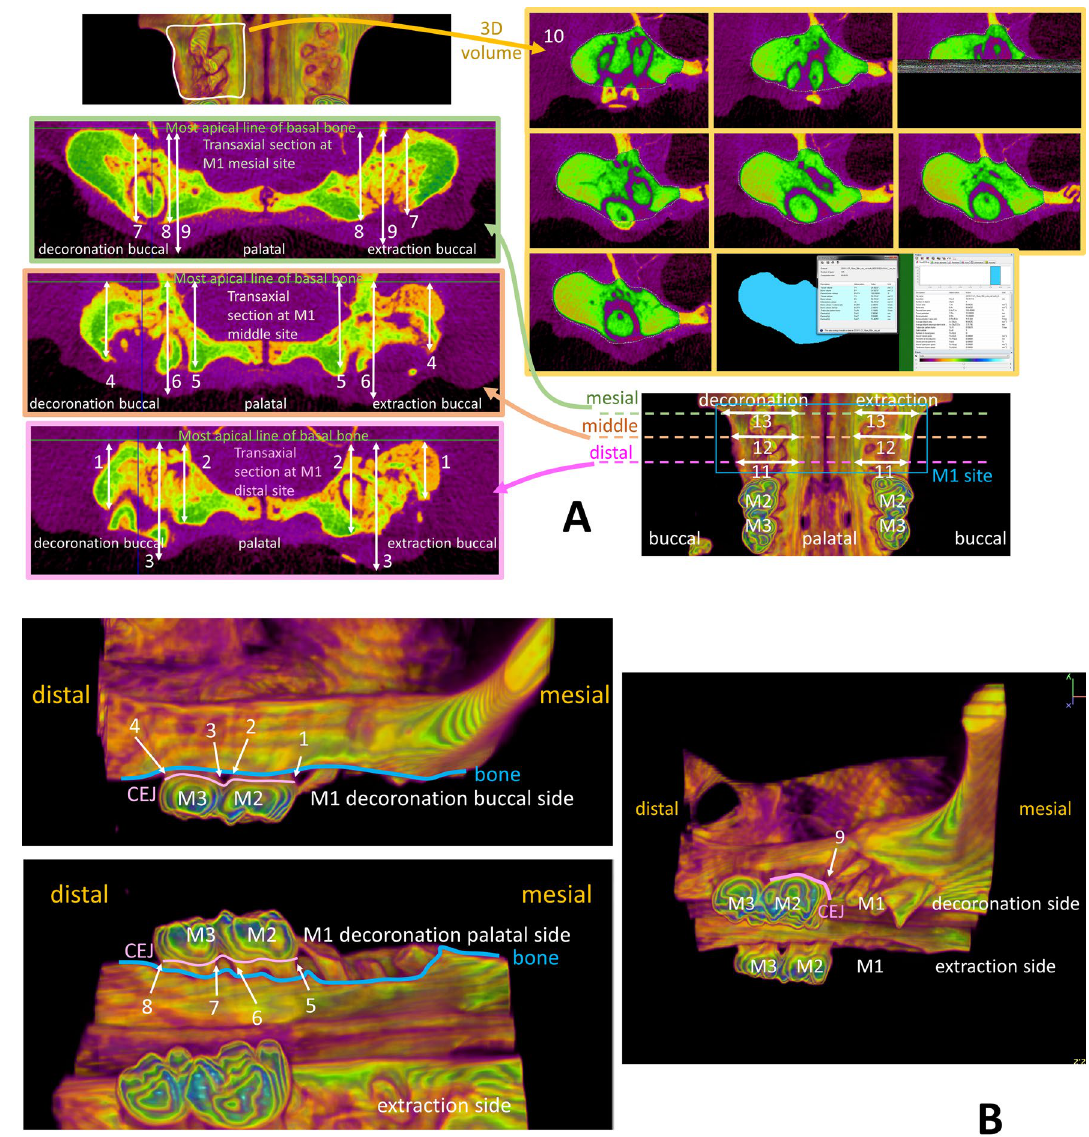
Figure 1. Micro-computed tomography assessments of alveolar bone and soft tissue dimension. ( A ) To evaluate the effectiveness of hard and soft tissue preservation of alveolar ridge dimension associated with the decoronation procedures, thirteen parameters were measured at maxillary first molar (M1) sites including (1) distal buccal bone height, (2) distal palatal bone height, (3) distal maximum soft tissue height, (4) middle buccal bone height, (5) middle palatal bone height, (6) middle maximum soft tissue height, (7) mesial buccal bone height, (8) mesial palatal bone height, (9) mesial maximum soft tissue height, (10) 3D bone contour volume*, (11) distal maximum alveolar ridge width, (12) middle maximum alveolar ridge width, and (13) mesial maximum alveolar ridge width. ( B ) To evaluate the influence of decoronation on the periodontal conditions of maxillary second molar (M2) and third molar (M3), the distances from marginal bone to cemento-enamel junction (CEJ) including (1) bM2mCEJ: M2 mesiobuccal CEJ to bone; (2) bM2dCEJ: M2 distobuccal CEJ to bone; (3) bM3mCEJ: M3 mesiobuccal CEJ to bone; (4) bM3dCEJ: M3 distobuccal CEJ to bone; (5) pM2mCEJ: M2 mesiopalatal CEJ to bone; (6) pM2dCEJ: M2 distopalatal CEJ to bone; (7) pM3mCEJ: M3 mesiopalatal CEJ to bone; (8) pM3dCEJ: M3 distopalatal CEJ to bone; and (9) the distance from CEJ to mesial furcation of M2 (M2mf) were measured. ( C ) To provide reference for alveolar critical size defect dimensions in a standardized and discriminative manner, five parameters were measured at the decoronated M1 site, including (1) middle bone height, (2) middle tissue height, (3) middle alveolar crestal width, (4) middle maximum bone width, and (5) mesio-distal socket length. *Three-dimensional (3D) bone contour volume was calculated on either side by adding up consecutive surfaces of interest on the transaxial section mesio-distally throughout the M1